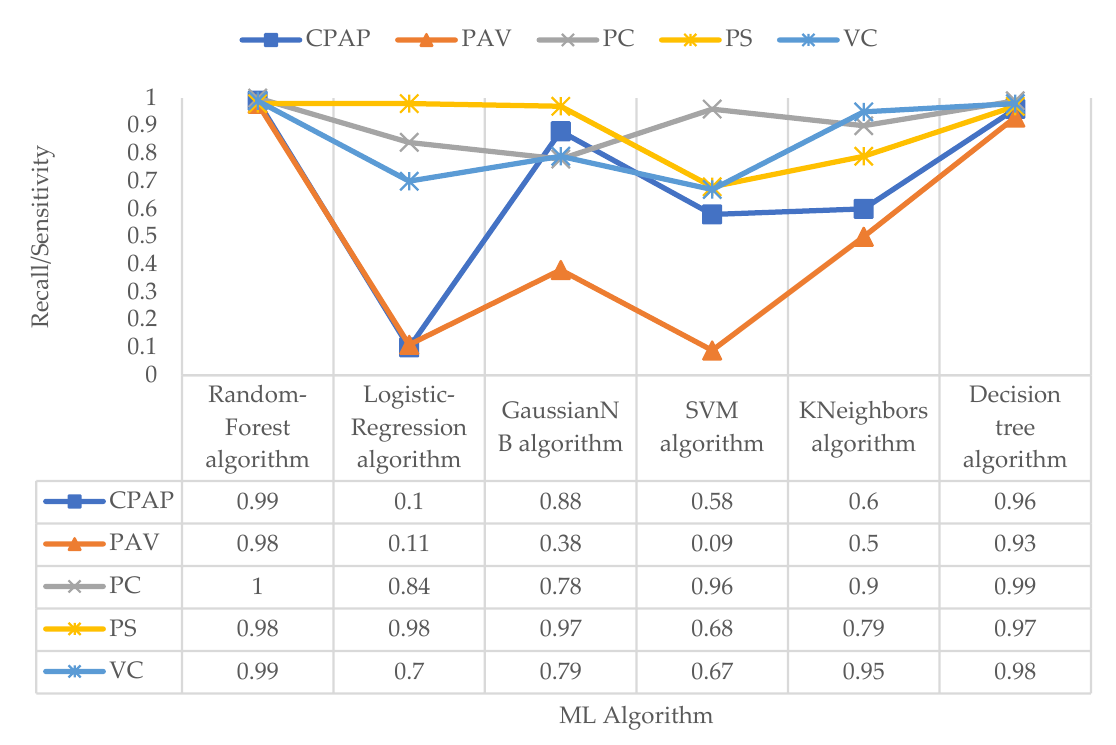
Figure 8. Model evaluation report of recall/sensitivity for different modes and ML algorithms.